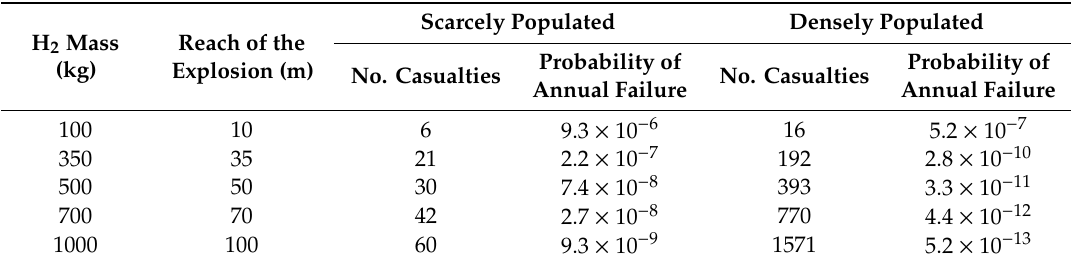
Table 6. Estimations of the consequences of accidents and of the acceptable annual probabilities of failure, adapted from [44].